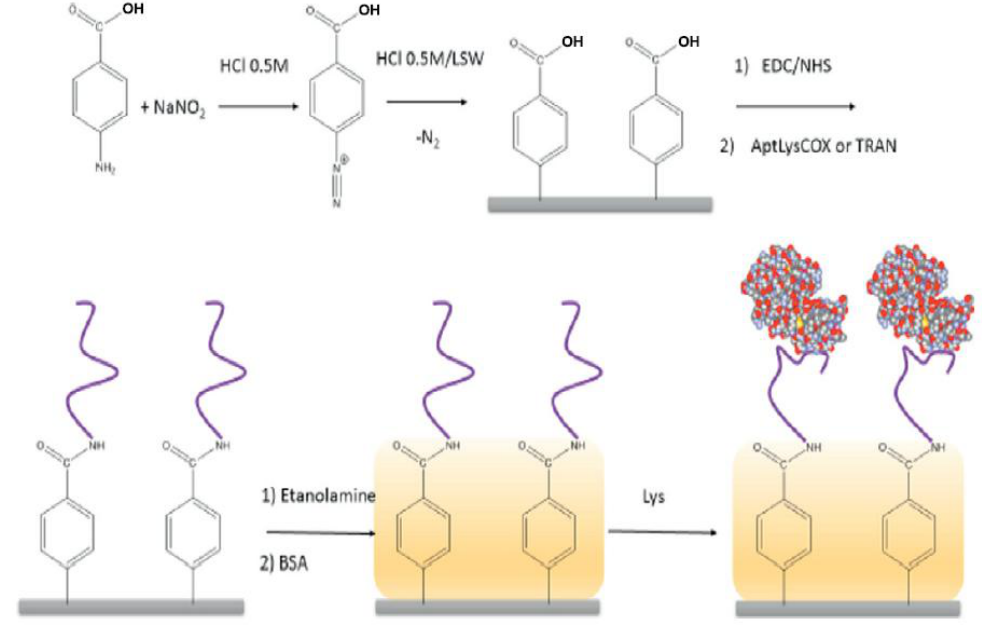
Figure 8. Impedimetric aptasensor developed for Lys determination on a 4-ABA-modified SPCE. Reprinted from [69] with permission.